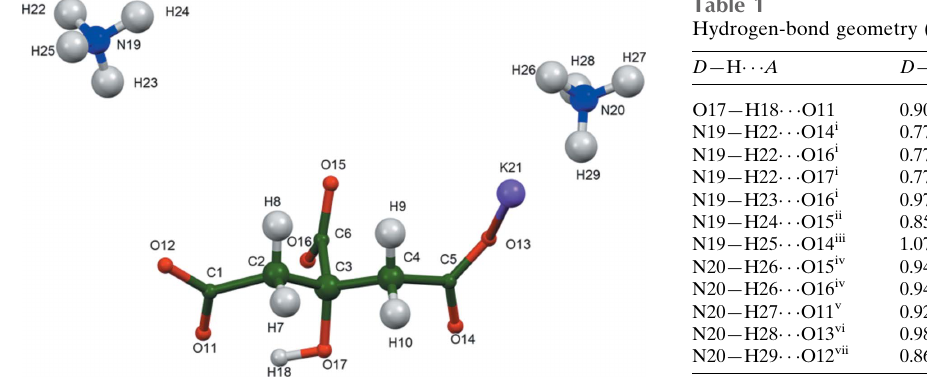
Figure 1 The asymmetric unit of (NH 4 ) 2 KC 6 H 5 O 7 with the atom numbering and 50% probability spheroids.